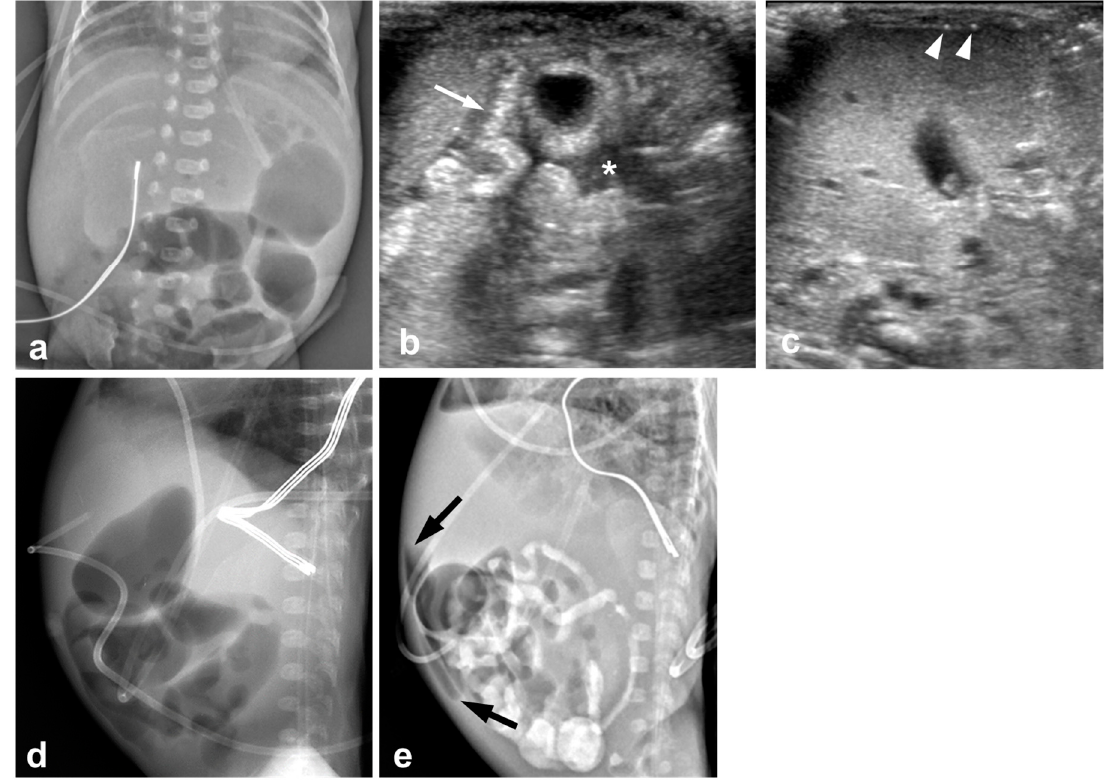
Figure 2. 12-day-old boy (born at gestational age of 24 weeks and 1 day) with perforated necrotizing enterocolitis and radiographic pneumoperitoneum; this infant died 11 days after laparotomy. ( a ) An abdominal radiograph obtained 1 day before US shows nonspecific distension of the bowels without free air. ( b , c ) Preoperative US images show increased intestinal wall echogenicity and wall thickening (arrow), complex ascites (asterisk), and free air (arrowheads) between the hepatic surface and the anterior abdominal wall. ( d ) Preoperative abdominal radiographs obtained 1 h after US show no pneumoperitoneum. ( e ) Pneumoperitoneum (arrows) appears on abdominal radiographs obtained 35 h after